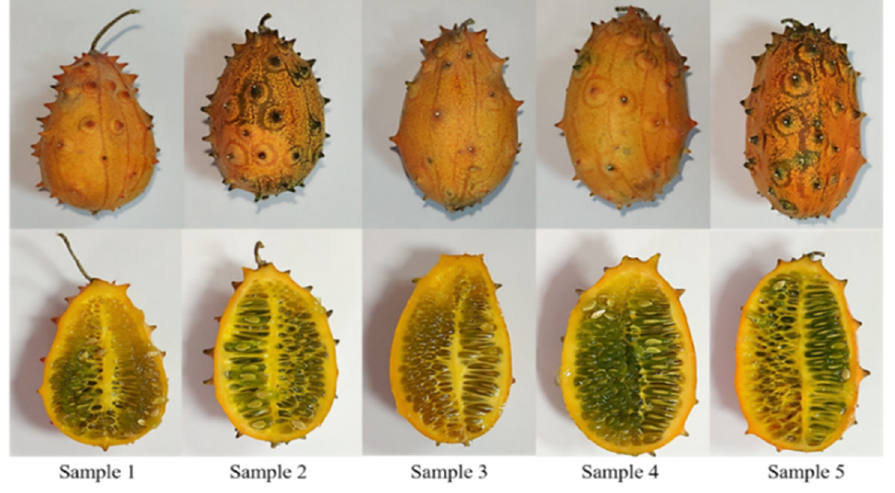
Figure 1. Horned melon samples.